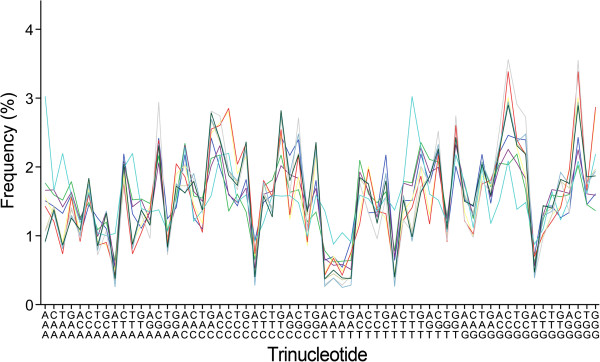
Trinucleotide frequency profiles of the genomes of species from the genus Synechococcus. Their genomic GC content varies from 49.63% to 60.84%. The profiles differ considerably from one another (10 members; cdiv = 0.215, SD = 0.190). None of the profiles complies well with either common profile 1 or common profile 2. For the explanation of abscissa see Figure
1.